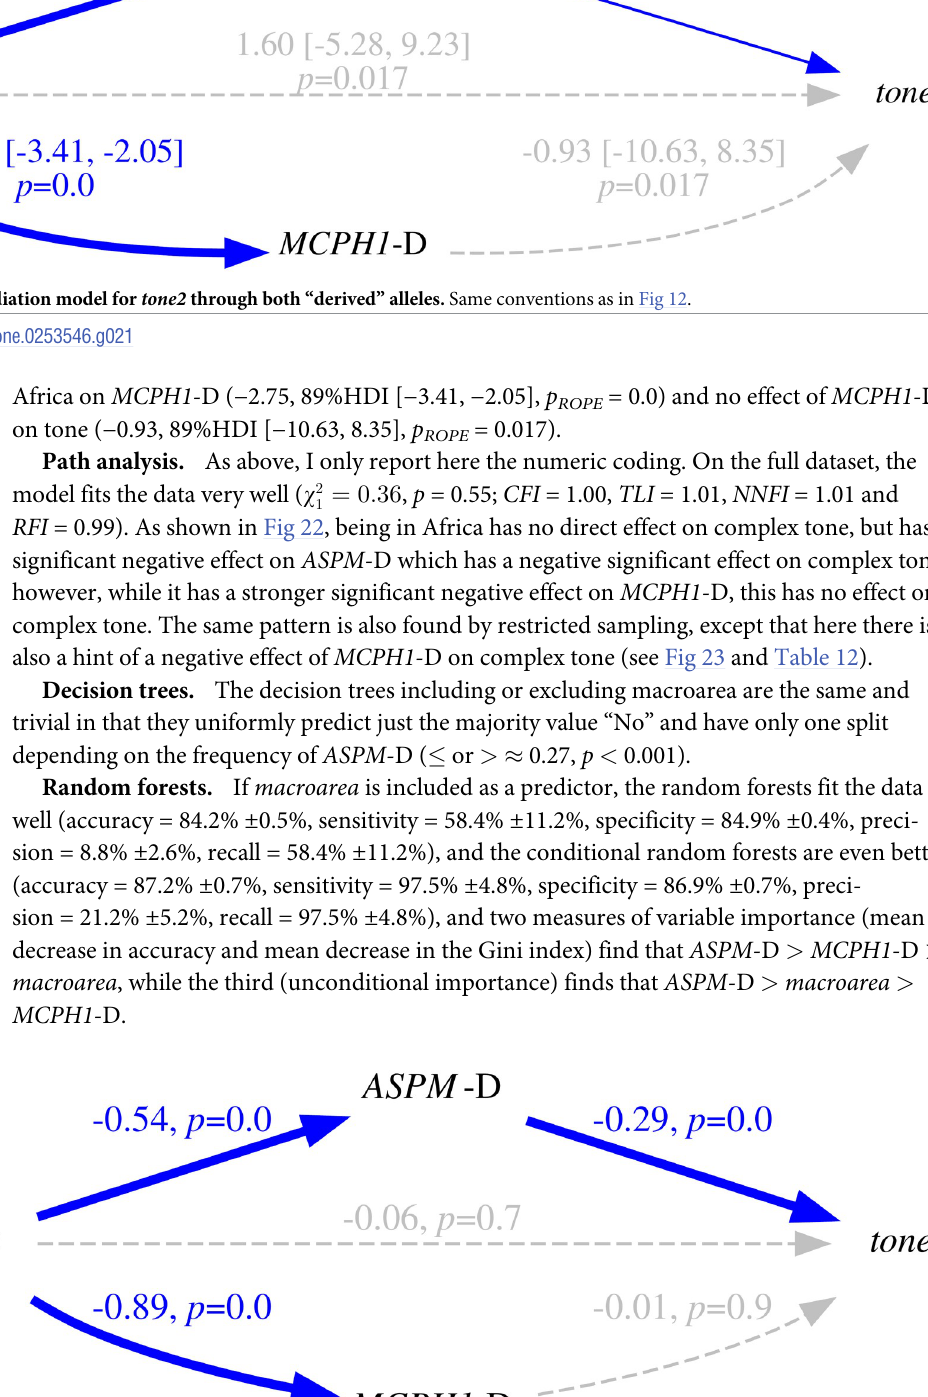
PLOS ONE | https://doi.org/10.1371/journal.pone.0253546 June 30,